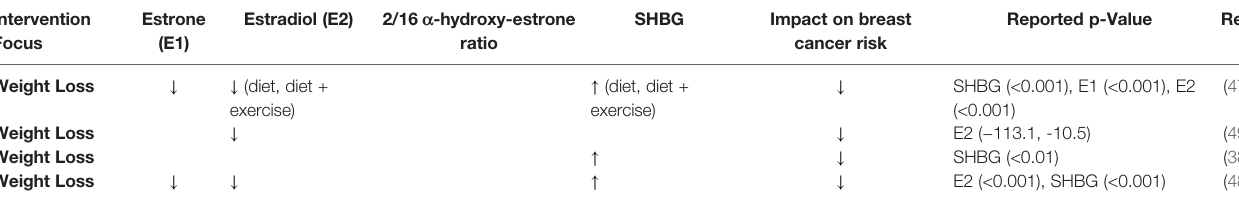
TABLE 5 | Breast cancer risk and estrogen level changes assessed in dual intervention studies.